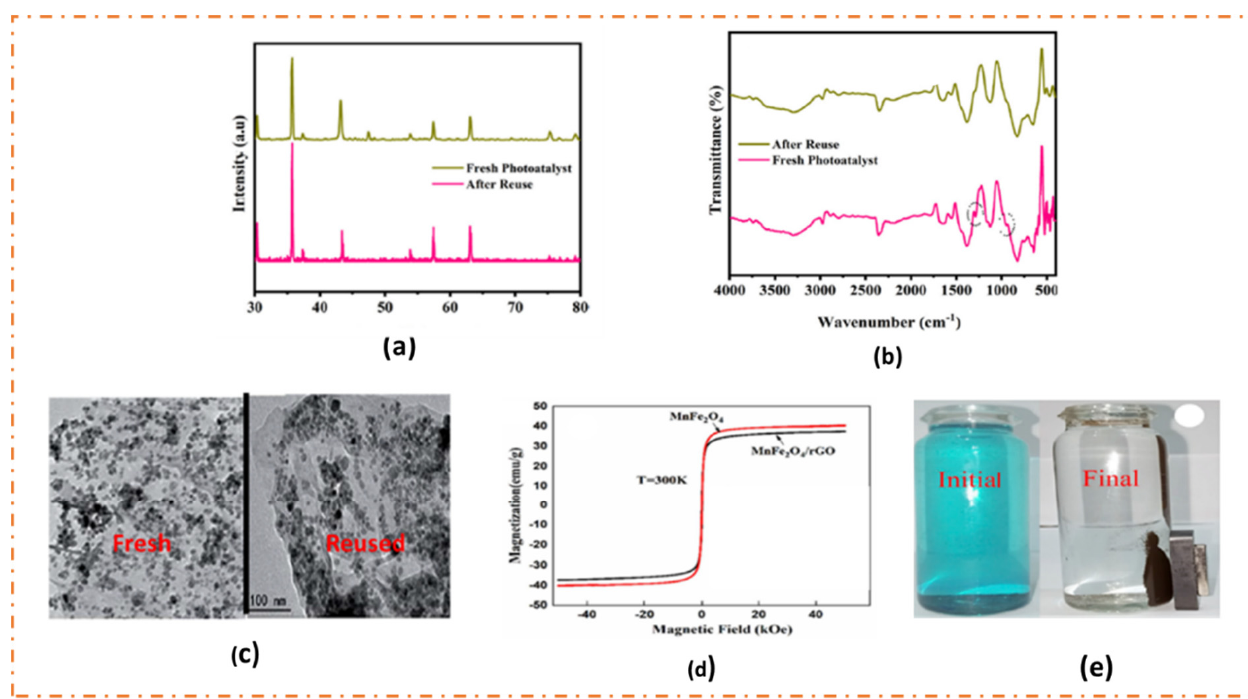
Figure 7. ( a ) XRD and ( b ) FTIR peaks of Ce-doped Nickel ferrite/rGO before and after reuse “Reprinted/adapted with permission from Ref. [64]. 2020, Elsevier”. ( c ) TEM images of fresh CoFe 2 O 4 /rGO before and after 6th generation of use “Reprinted/adapted with permission from Ref. [31]. 2017, RSC”. ( d ) Magnetic hysteresis of MnFe 2 O 4 and MnFe 2 O 4 /rGO composite “Reprinted/adapted with permission from Ref. [89]. 2019, Elsevier”. ( e ) Recovery of nickel ferrite/rGO composite from dye-degradation system using a magnet “Reprinted/adapted with permission from Ref. [90]. 2020, Elsevier”.